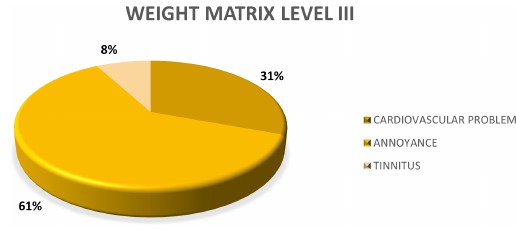
Figure 6: Level III weights (daytime